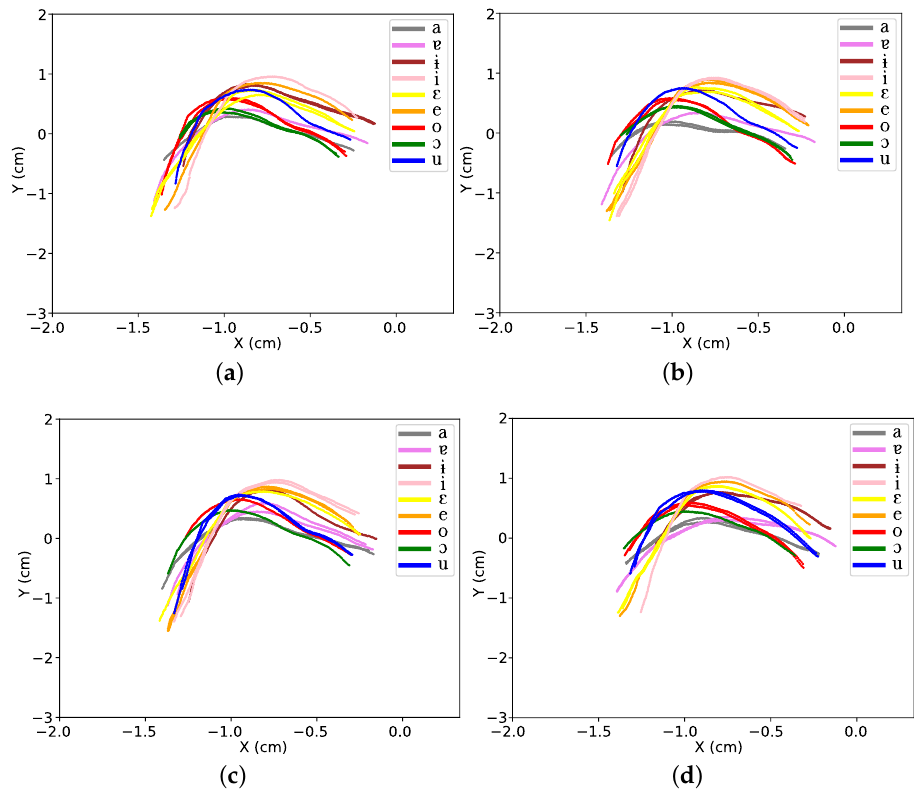
Figure 6. Example of one tongue contour by vowel for each context for speaker Y1. ( a ) pVpv context;